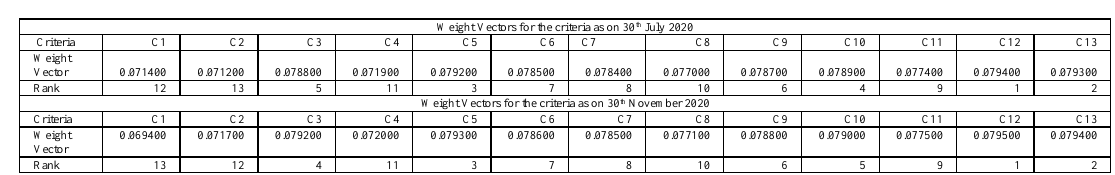
Table 3. Weight Vectors for the